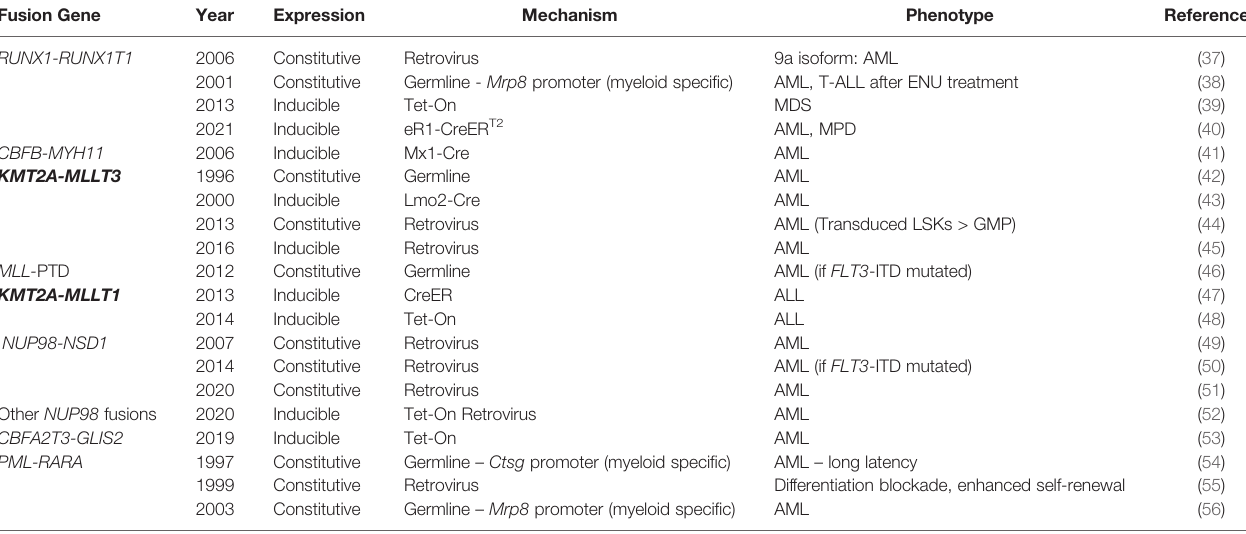
TABLE 1 | Mouse models of fusion genes. Fusion